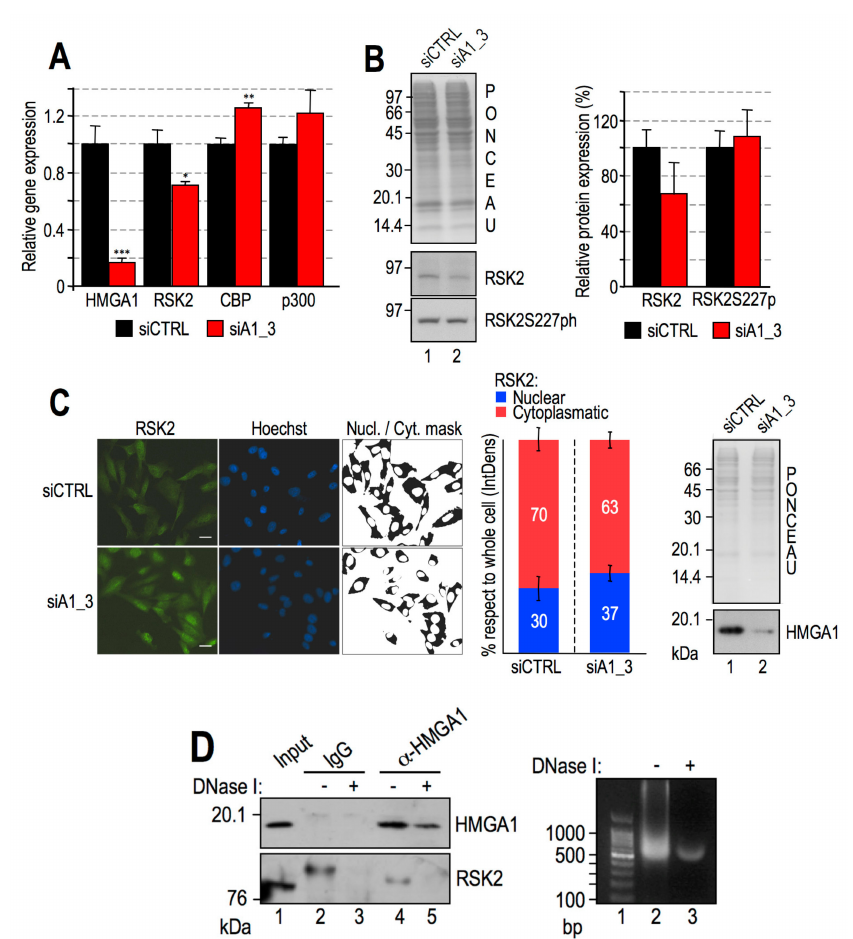
Figure 8. High Mobility Group A1 (HMGA1) modulates histone post-translational modifications (PTMs) acting downstream of Ribosomal protein S6 kinase alpha-3 (RSK2) phosphorylation. ( A ) Relative